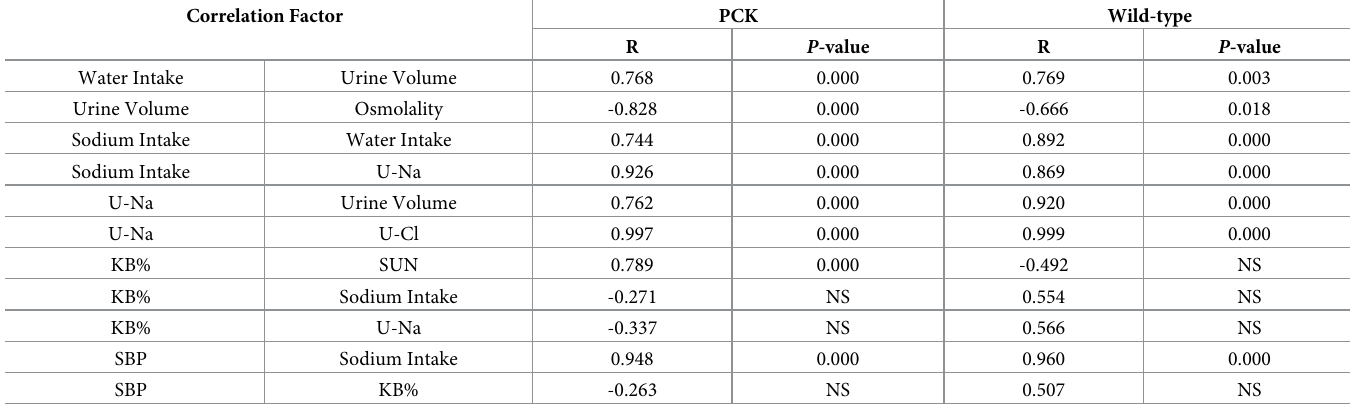
Table 2. Correlation between two factors in PCK and wild-type